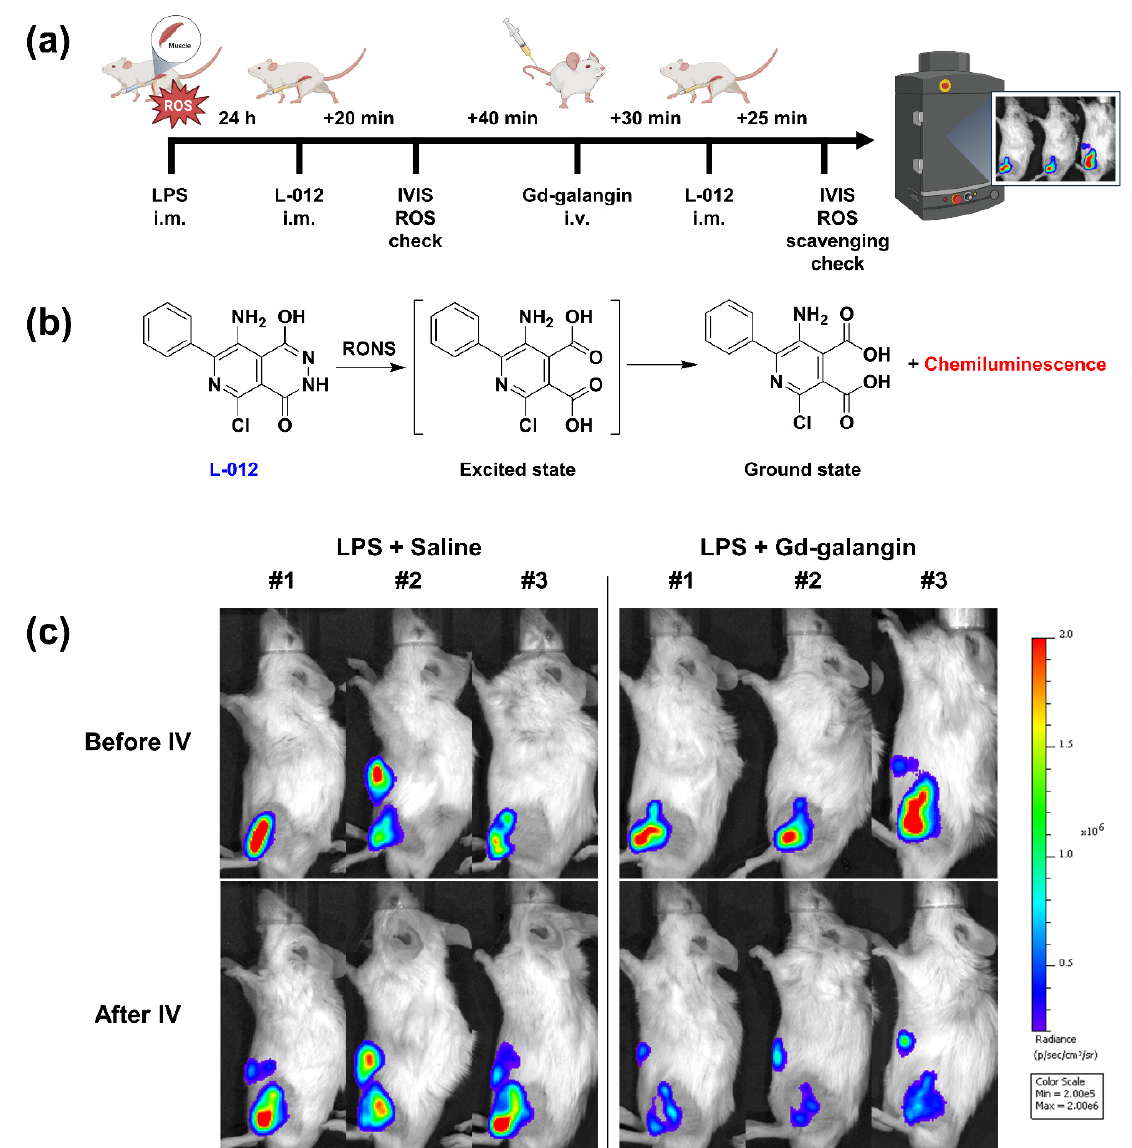
Figure 5. ( a ) Time points for intramuscular injection (i.m.) and intravenous injection (i.v.). ( b ) On the use of L-012, a luminol-based chemiluminescent probe, for detecting reactive oxygen (and nitrogen) species. ( c ) Chemiluminescence images of reactive oxygen species (ROS) using L-012.